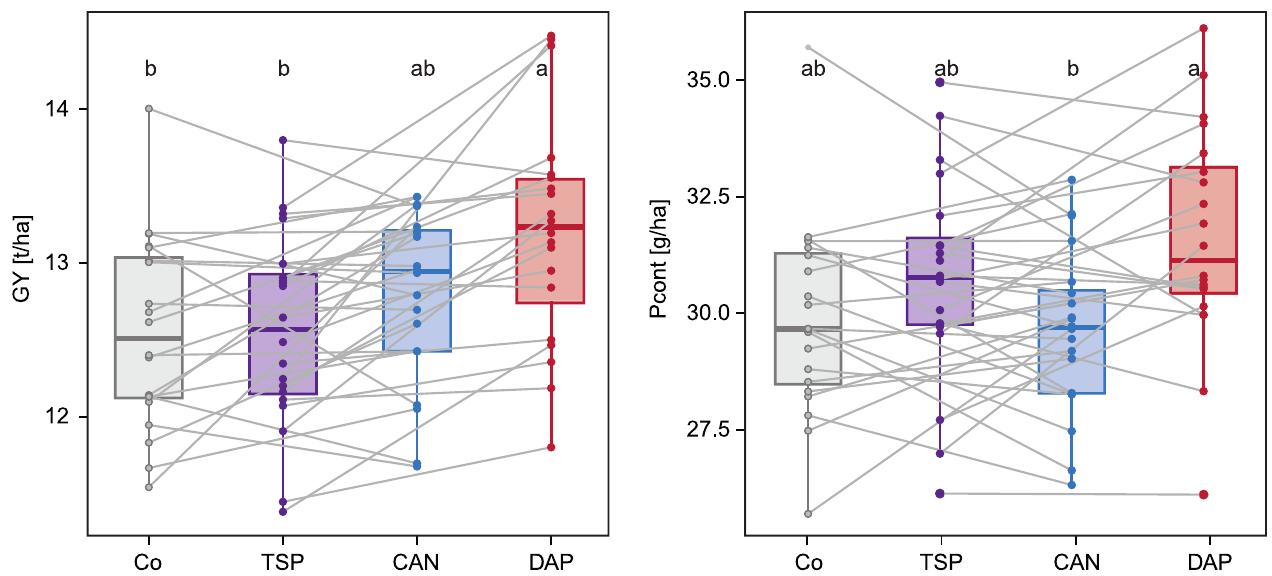
Fig 3. Visualization of the genotype-by-starter fertilizer interaction. Boxplots for grain yield (GY) and P grain content (Pcont) by starter fertilizers: control (Co, grey), triple superphosphate (TSP, purple), calcium ammonium nitrate (CAN, blue), diammonium phosphate (DAP, red). Interaction terms are visualized by connecting trait values of the same varieties with a grey line. Note that for the sake of clarity lines are only drawn between every other treatment. Different letters indicate significant (p-value < 0.05) differences between starter fertilizers means.